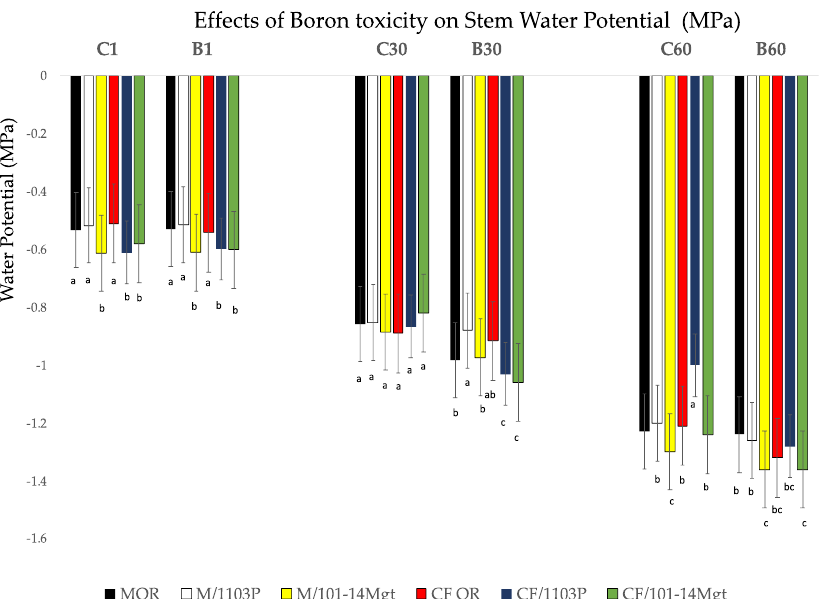
Figure 4. Boron toxicity effects on midday stem water potential of Merlot (M) and Cabernet Franc (CF) grapevine cultivars on their own roots (OR) and on 1103P and 101-14 Mgt rootstocks at three stages. C represents the control treatment; B represents the boron treatment. 1, 30, 60 (at day one, thirty and sixty, respectively). Different letters represent significant differences at p < 0.05.